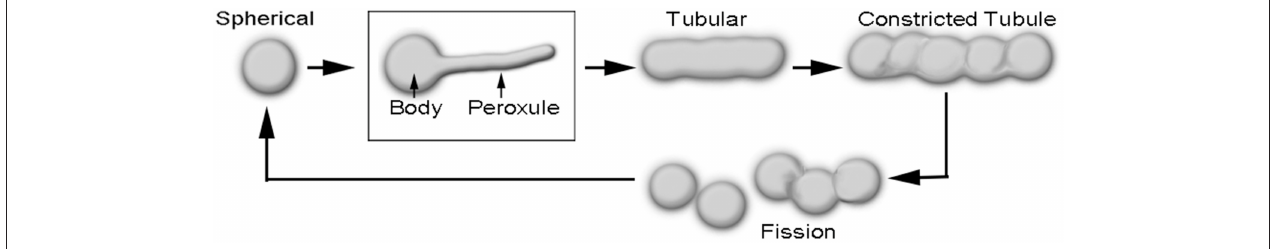
FIGURE 1 | Diagrammatic depiction of sequential changes in peroxisome morphology leading to their fission and proliferation. Peroxules extend and retract from a spherical peroxisome body and thus represent a transient, intermediate state between the spherical and the completely tubular, pre-constriction form of